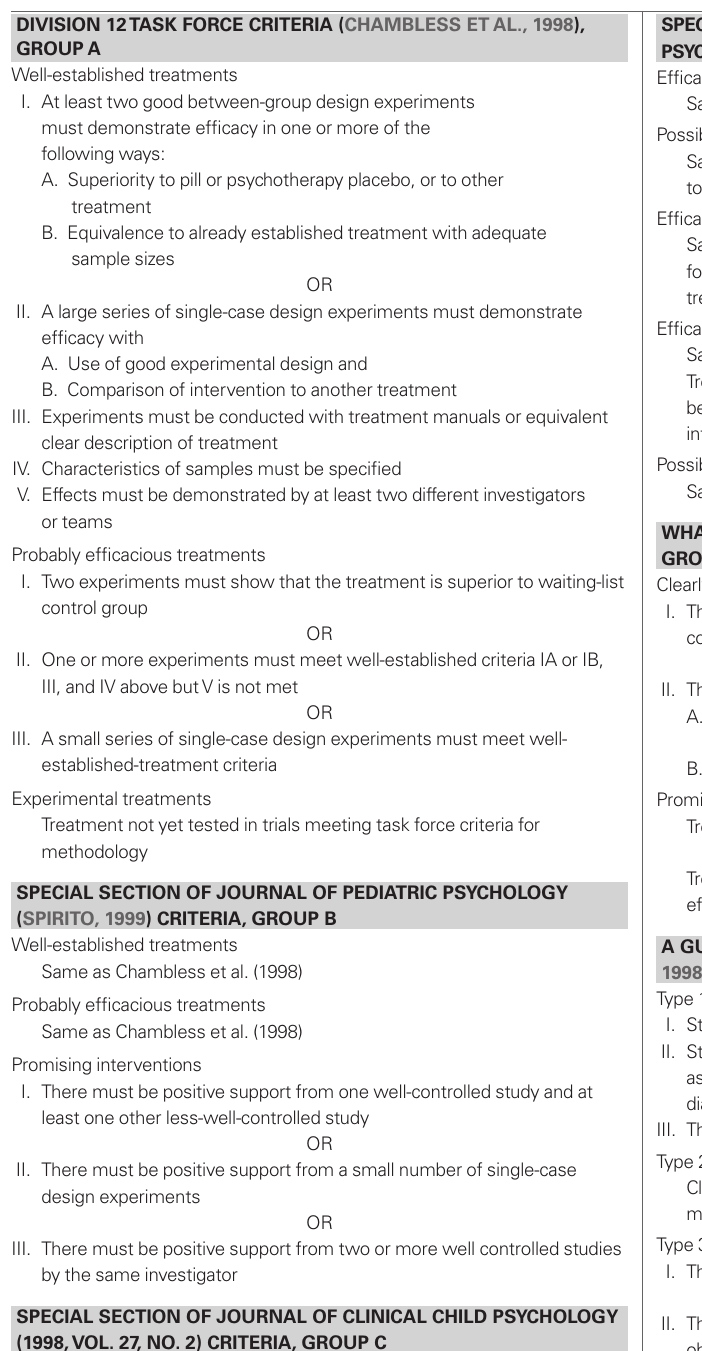
Table 2 | Workgroup criteria for identification of empirically supported therapies (source: Chambless and ollendick,